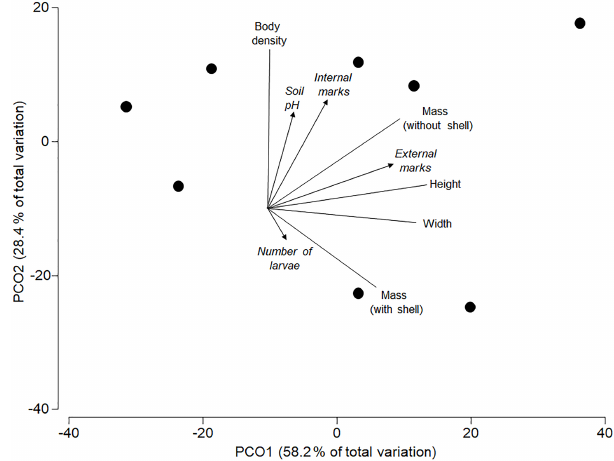
Figure 3. Principle coordinates ordination based on a resemblance matrix (Gower distances) from morphometric traits (shell height and width in millimetres, shell mass in grams, mass without shell in grams and body density in mass:volume ratio) in the studied sub- populations. Vectors for morphometric traits (without arrow) and predictors (with arrow: soil pH, % internal utilization and exter- nal attack marks) were superimposed based on Pearson correlations with axis scores of the individual